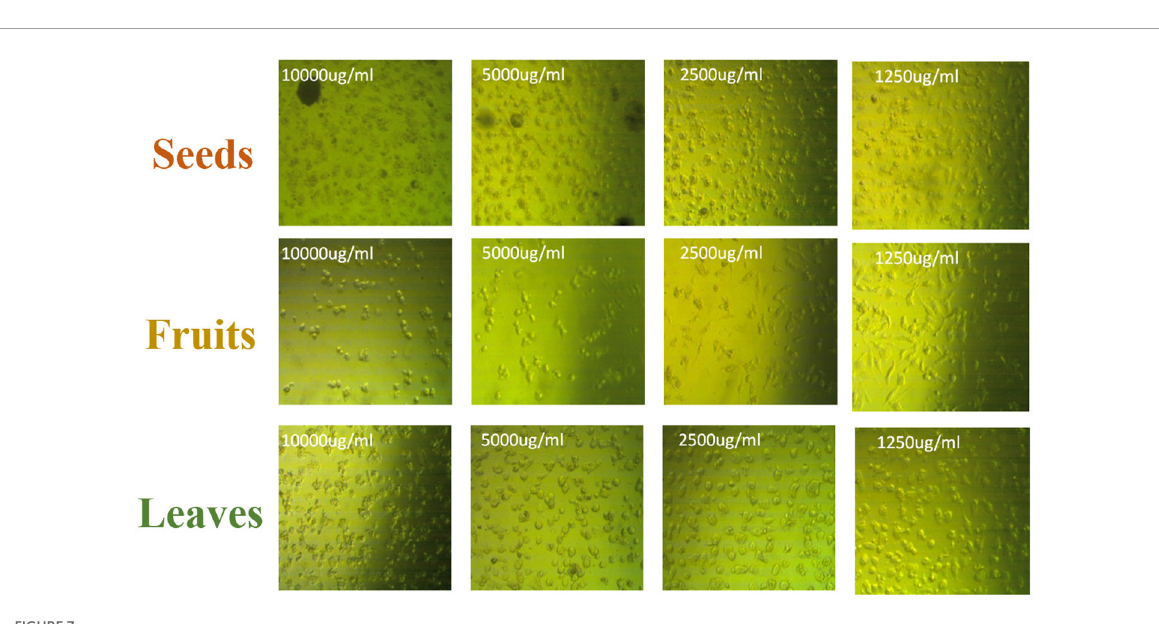
( Figures 11 , 12 ). The highest effects were presented by leaf extracts, followed by seed and fruit